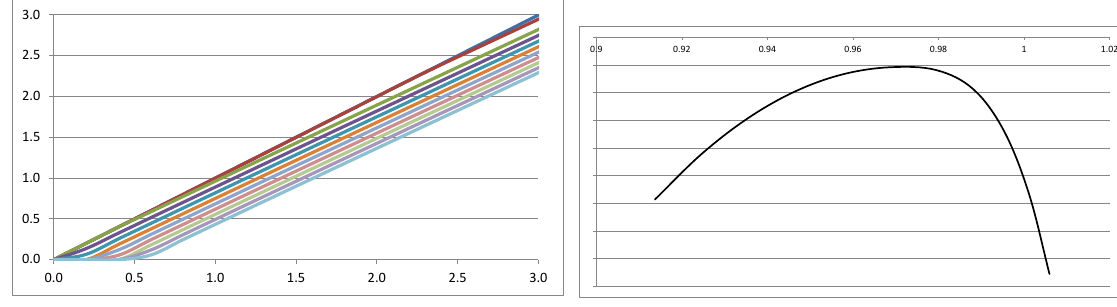
Figure 2. Case of large individual risk aversion parameter α = 0 . 4 > β = 0 . 0301